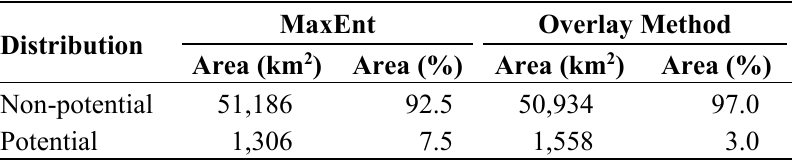
Table 4. Areas of the potential distribution of Picea chihuahuana Martínez at local scale estimated by MaxEnt and overlay method.